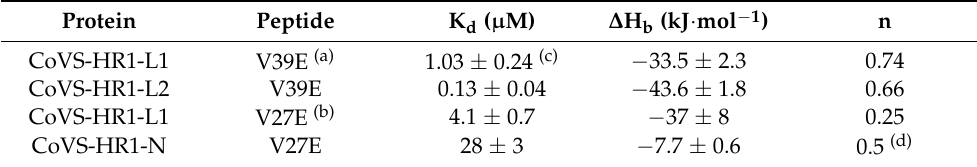
Figure 6. Isothermal titration calorimetry (ITC) experiments of the binding of the HR2 V39E peptide to the CoVS-HR1 proteins. ( a , b ): Baseline-corrected ITC thermograms measured for the titration of L1 ( a ) and L2 ( b )m showing exothermic peaks associated with protein–peptide binding. ( c , d ) Binding isotherms for L1 ( c ) and L2 ( d ) calculated according to the respective thermograms. The plots show the binding heats normalized per mole of added peptide versus the peptide-to-protein molar ratio. The black symbols represent the experimental heats, and the red lines represent the fittings using a binding model of n identical and independent sites. Table 1. Apparent thermodynamic parameters of binding of the HR2 peptides to CoVS-HR1 proteins measured by ITC at 25 °C. The parameters correspond to the best fittings of the binding isotherms using a binding model of n identical and independent sites.